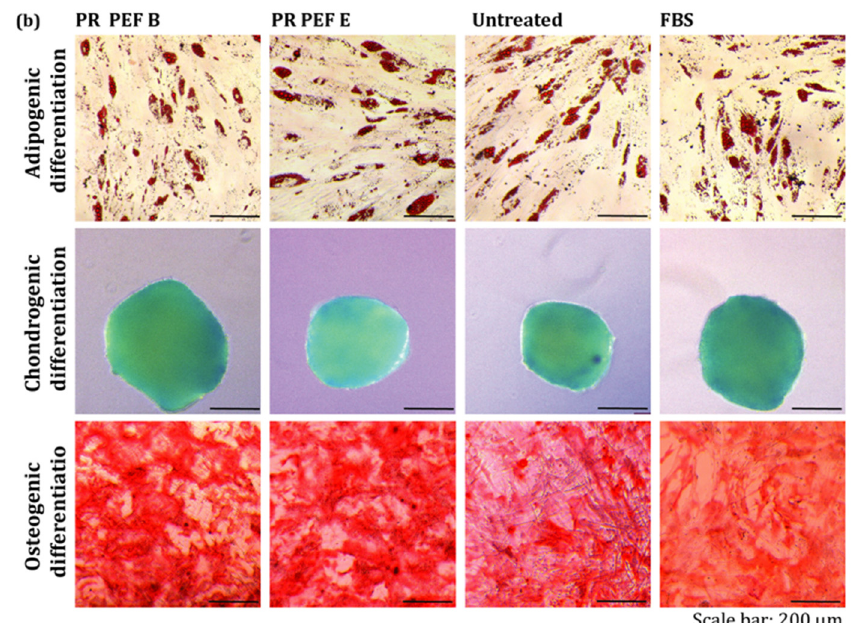
Figure 4. Differentiation potential of BM-MSCs cultured in media supplemented with PR obtained after PEF application and FBS. ( a ) Flow cytometry analysis of MSC markers, CD29, CD73, CD90, CD105, CD34, CD45, and HLA-DR. ( b ) Differentiation potential to adipogenic, osteogenic, and chondrogenic lineages by oil red O, alizarin red S, and Alcian blue staining, respectively.